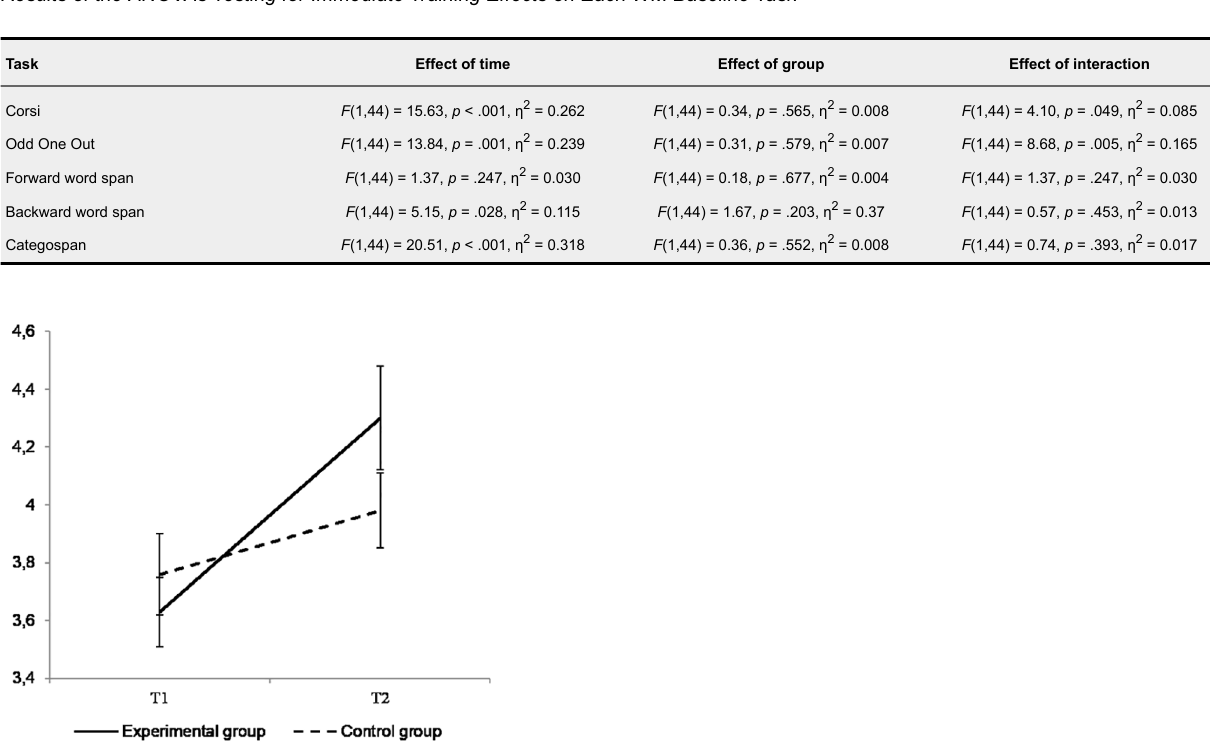
Results of the ANOVAs Testing for Immediate Training Effects on Each WM Baseline Task